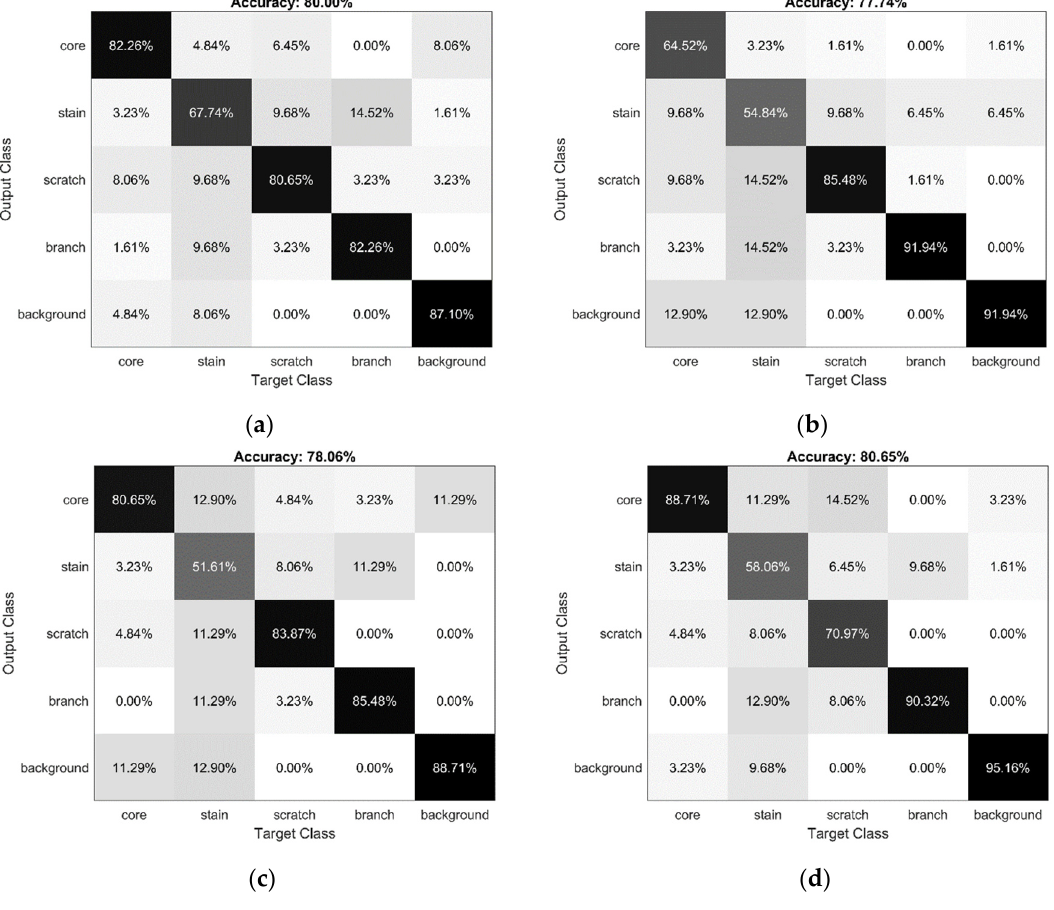
Figure 17. Confusion matrices of classification results while using ( a ) AlexNet; ( b ) VGG16; ( c ) BNInception; ( d ) ResNet152.